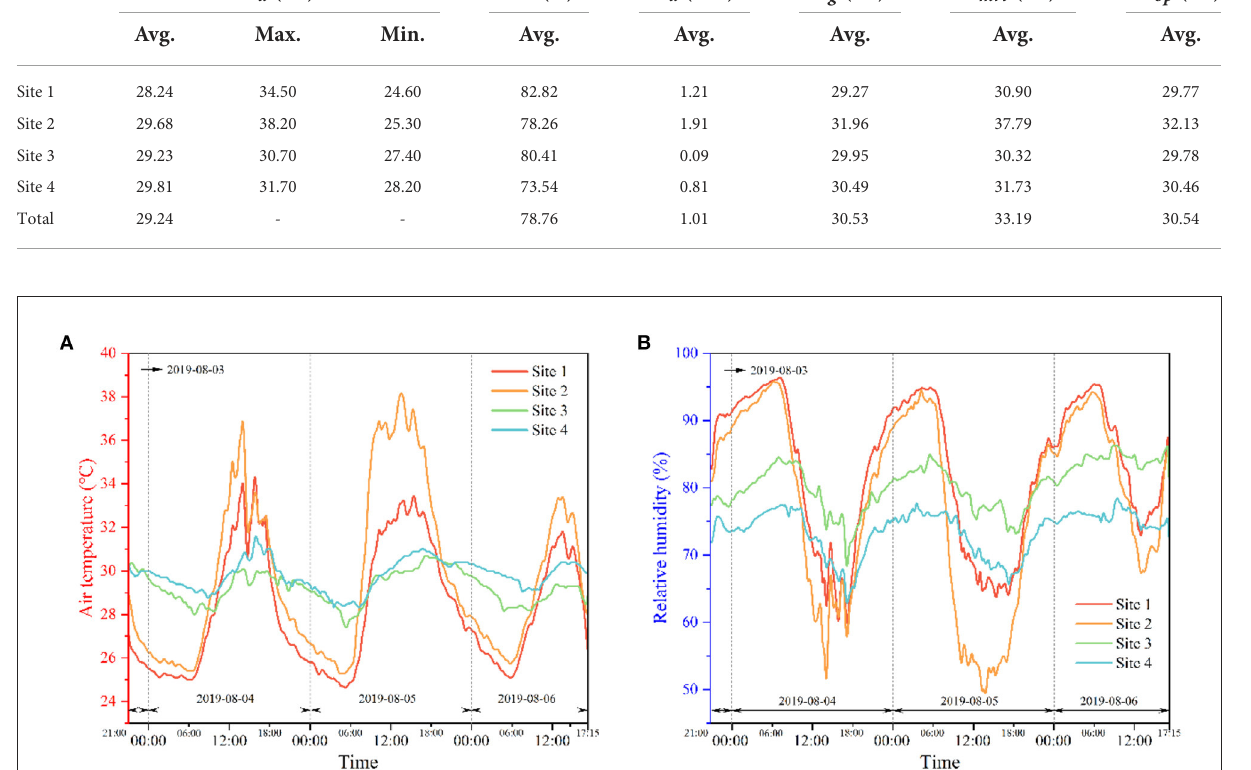
FIGURE6 Comparison of T a and RH at four measuring sites during the measured period (A) T a , (B) RH .